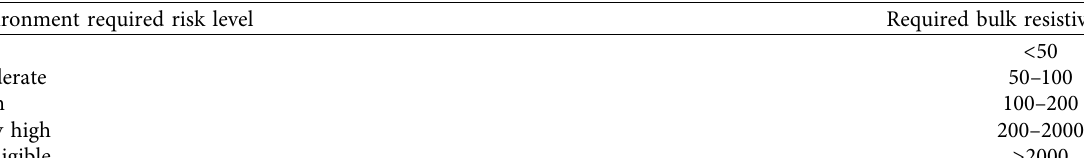
Table 4: Classification based on environment risk level.